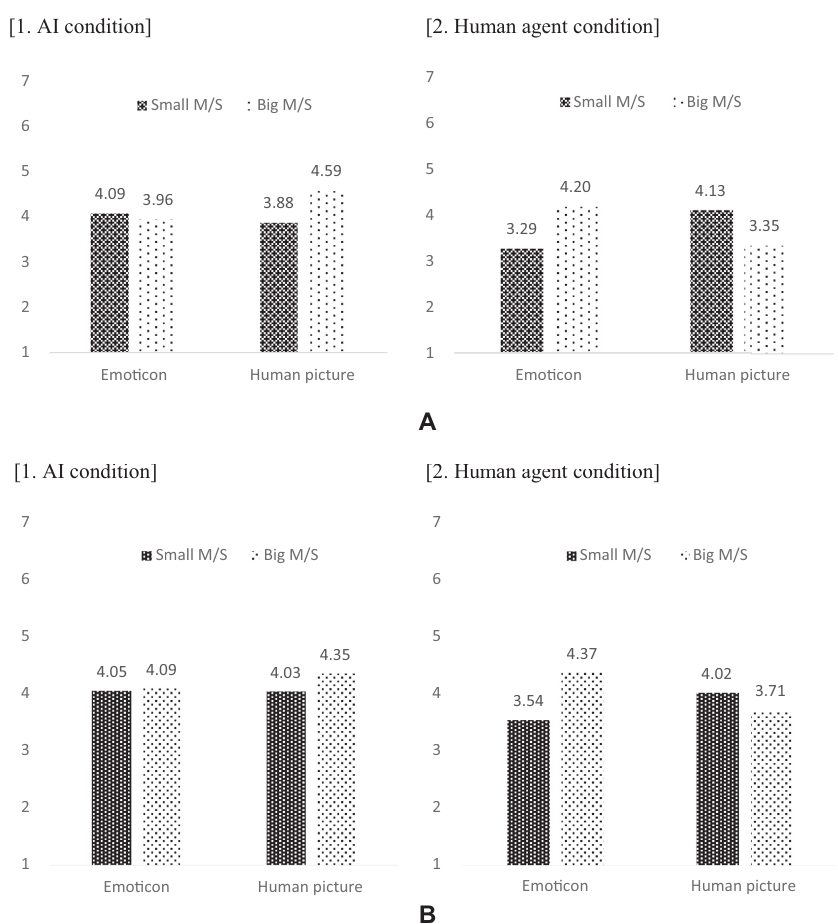
Fig. 3. A. Perceived service quality (study 2). B. Customer satisfaction (study